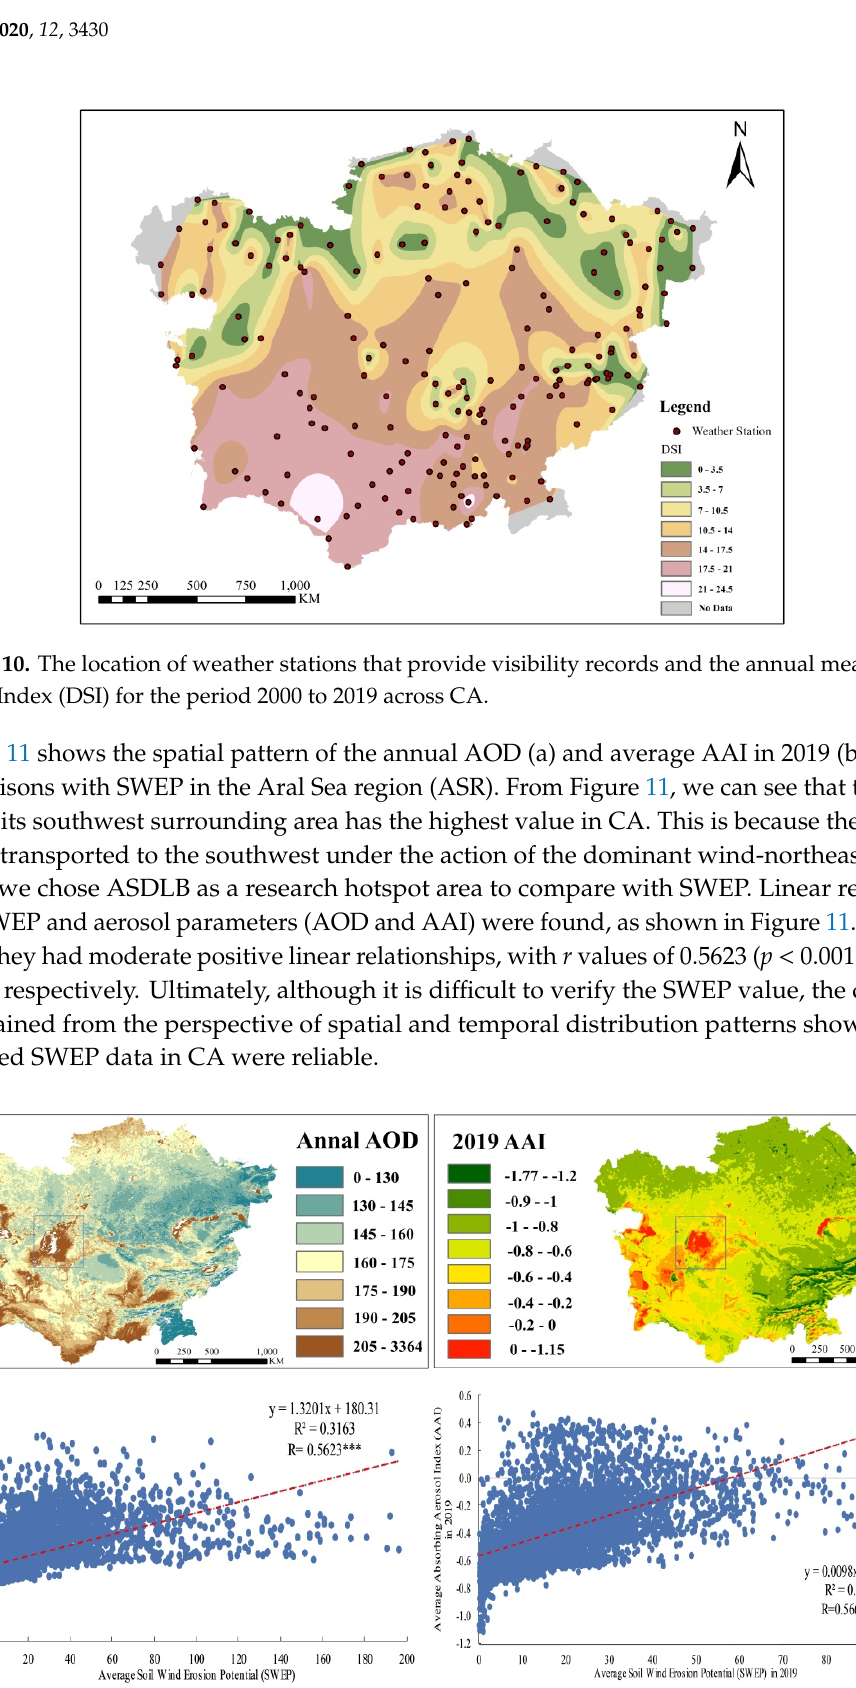
Figure 11. The spatial distribution of the annual average MODIS Aerosol Optical Depth (AOD) ( a ) and Sentinel-5P Absorbing Aerosol Index (AAI) of 2019 ( b ), and the comparisons of the average SWEP AOD and AAI in the Aral Sea region.